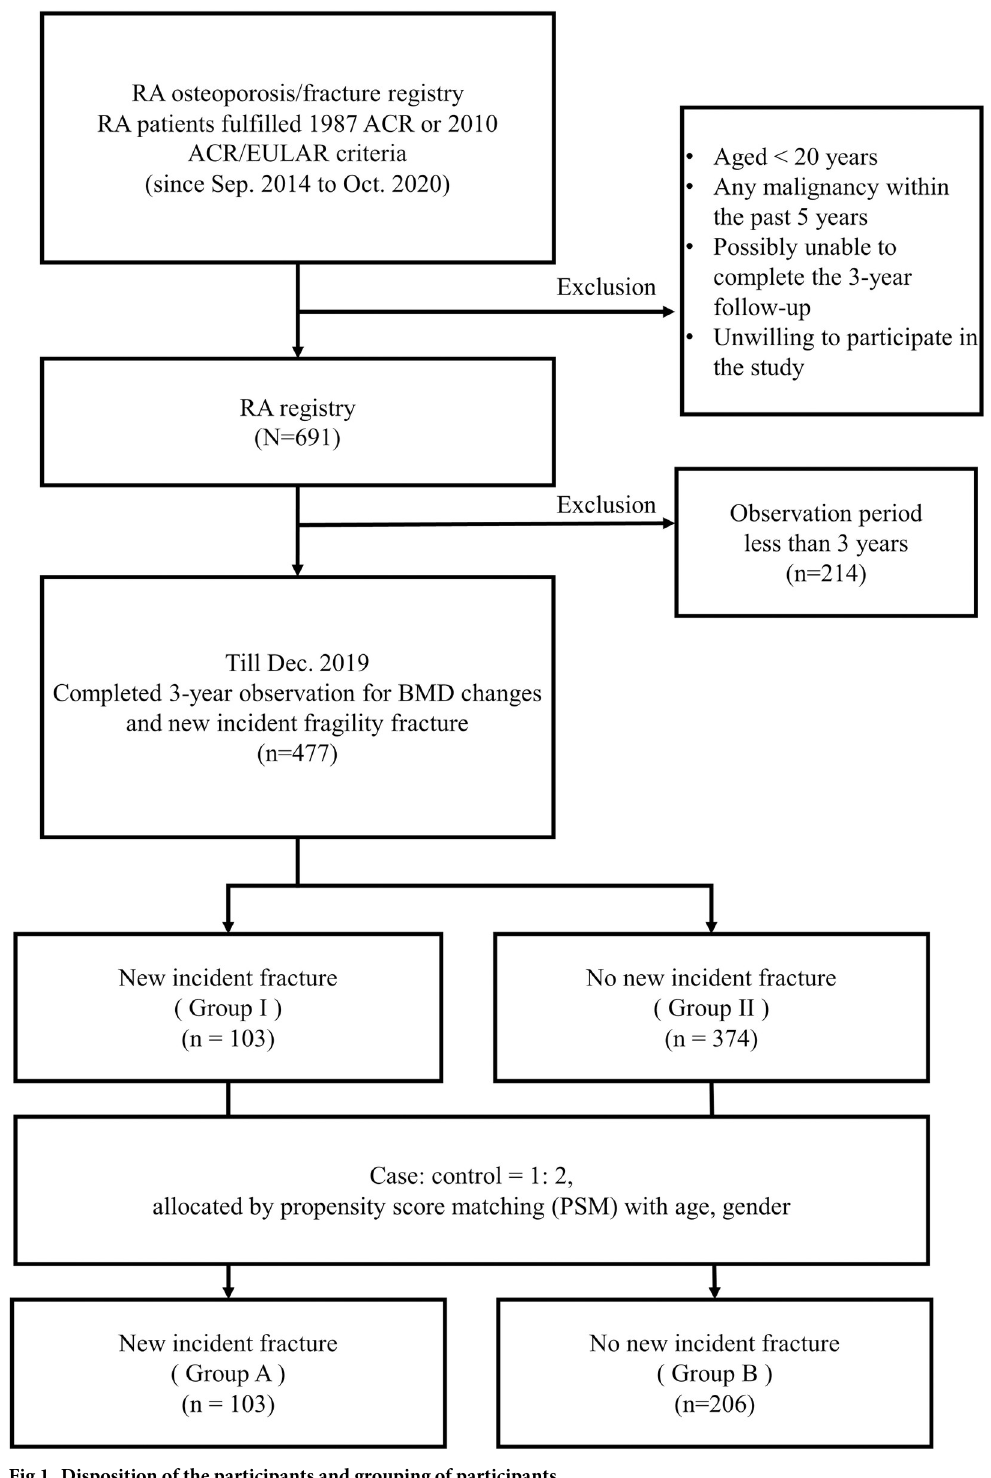
Fig 1. Disposition of the participants and grouping of